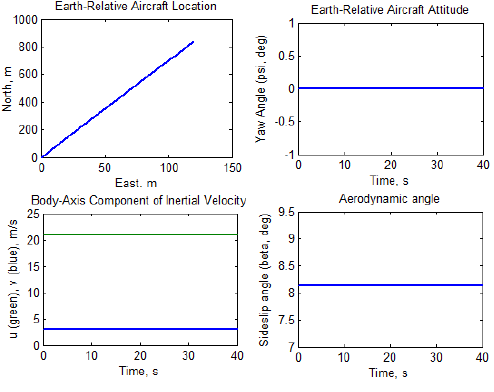
Figure 8: Position error when employing the Wind Correction Controller -